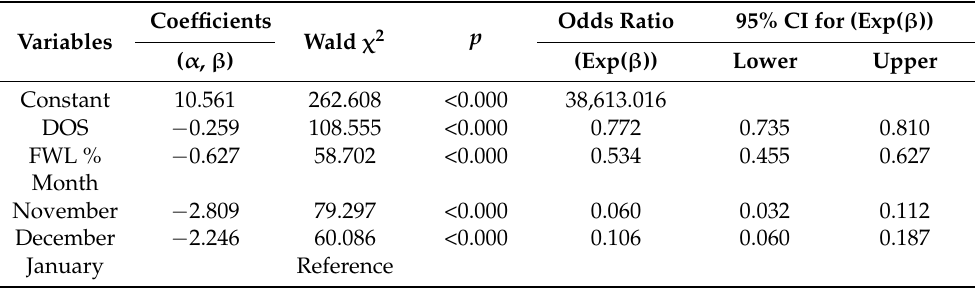
Table 10. Estimation of the multiple logistic regression parameters for the Levantino and Litoral cucumber cultivars.